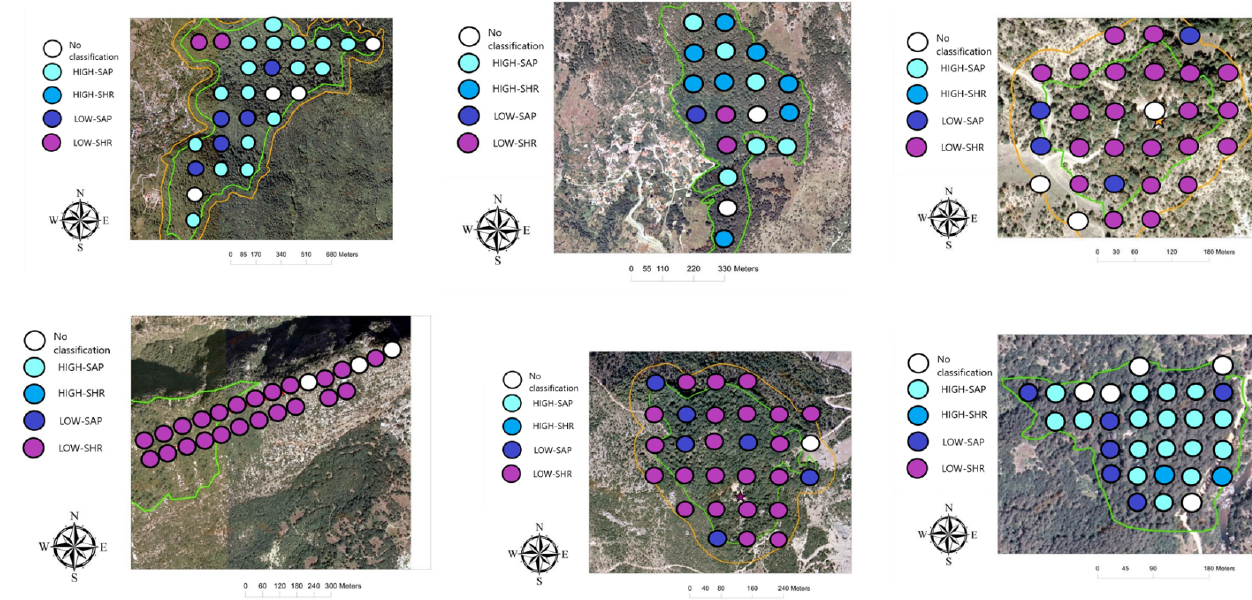
Figure H1. The six maps show how the woody plant groups are spatially located in the six sacred forests. Top row from the right: Greveniti, Palioseli, Vitsa; bottom row from the right: Kapesovo, Mazi, Vovoussa. © Google Earth based on own